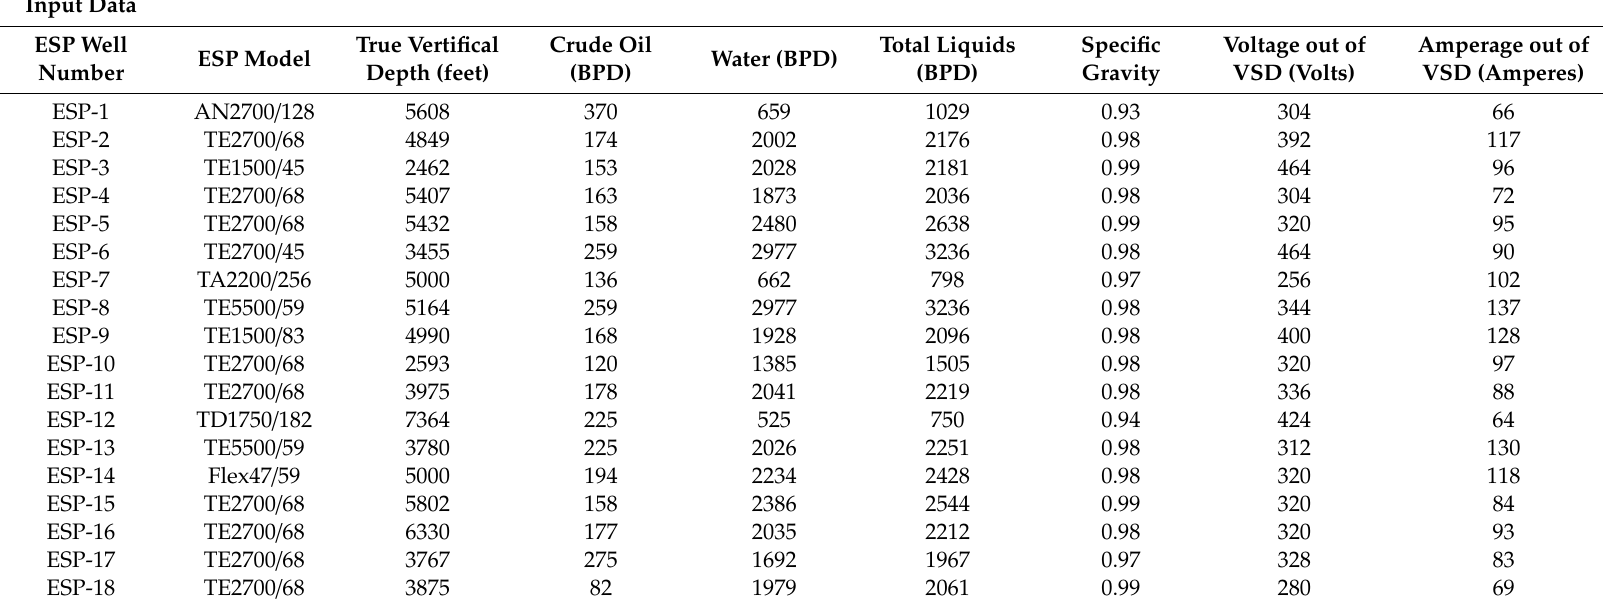
Table A3. Input data for detailed ESP system energy